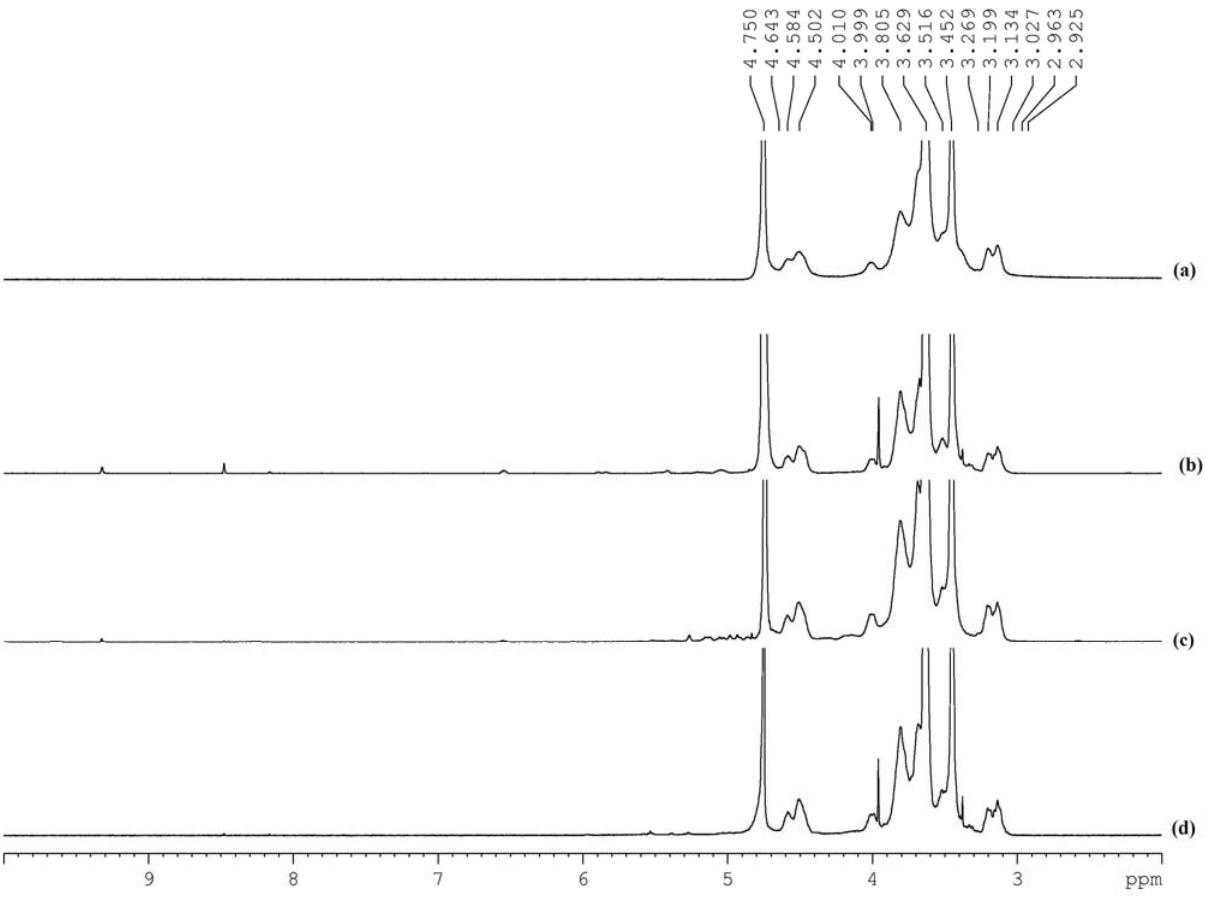
Figure 5. Influence of aging in solid state on the 1 H NMR spectrum of oxidized methylcellulose. (a) initial methylcellulose; (b) direct spectrum of 25% oxidized methylcellulose; (c) 25% oxidized methylcellulose after aging; (d) the same sample dissolved in presence of NaOD. Solvent: D2O; temperature 30 °C. Two arrows indicate the specific signals of oxidized methylcellulose (see b and